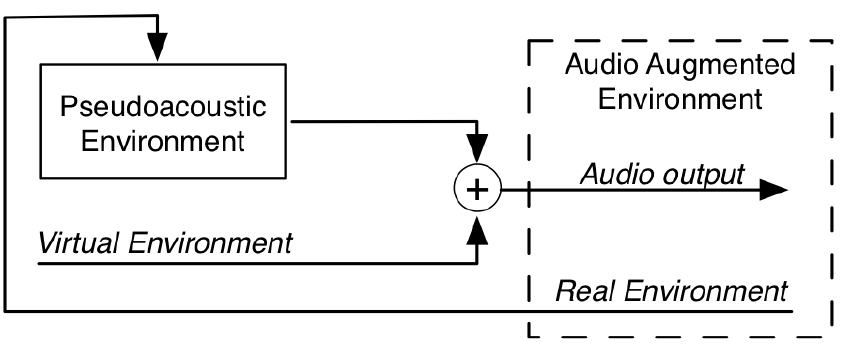
Figure 1. The legacy ARA mixing process